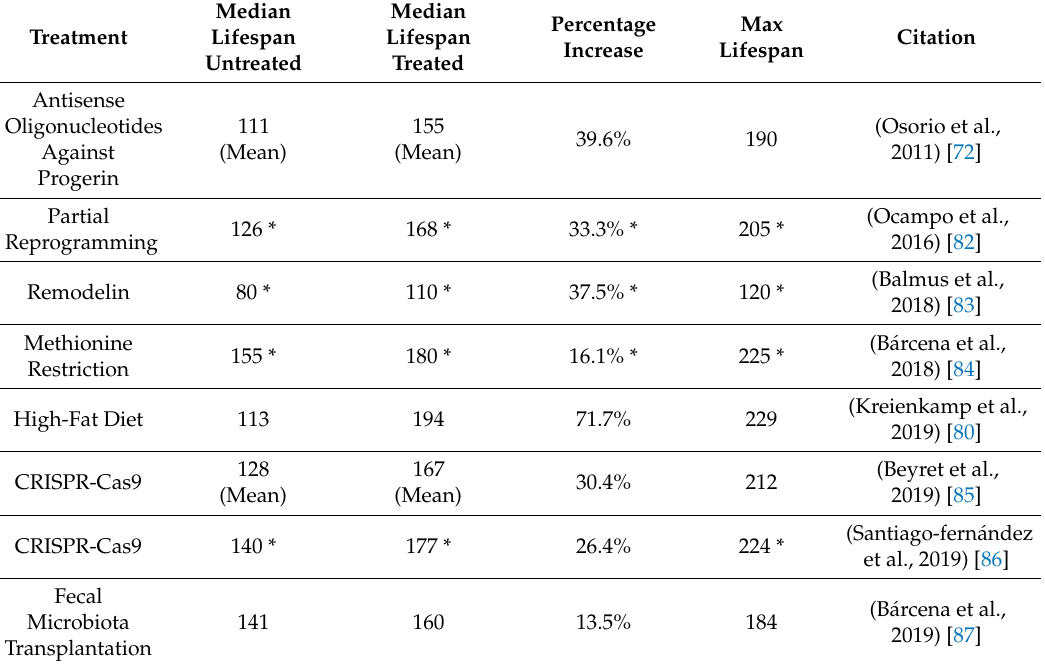
Table 1. Therapeutic treatments and their e ff ect in Lmna G609G / G609G mice.